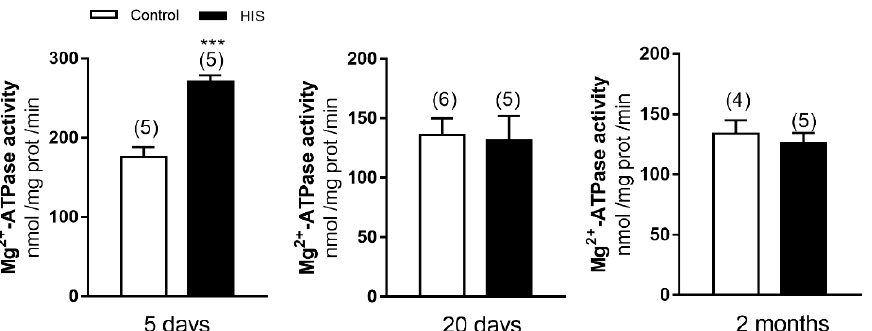
Figure 5. Status of Mg 2+ -ATPase activity in neonatal cortex 5 and 20 days after HIS and in 2-month- old animals. Bar graphs show the effect of HIS on Mg 2+ -ATPase activity measured 5 days and 20 days after HIS (PD 17 and PD 32, respectively) and in 2-month-old animals (PD 60). Data are mean ± SEM. values from 4 to 6 different neonates from independent litters. *** p < 0.001 is significantly different from control using unpaired two-tailed Student’s t -test.